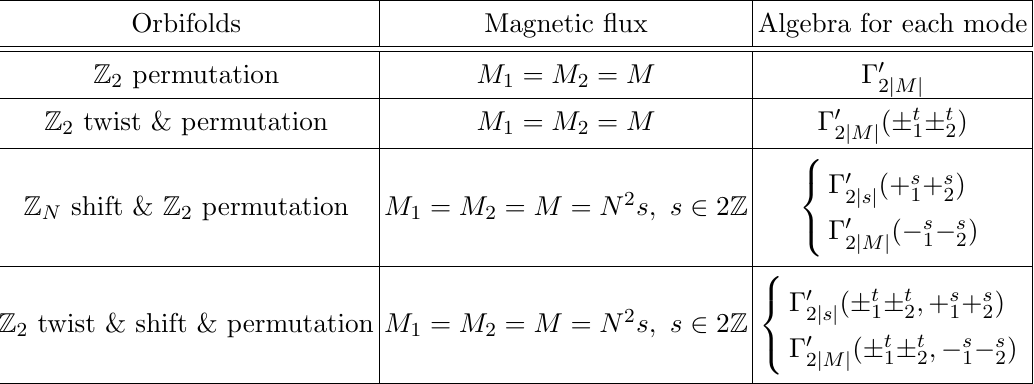
Table 3 . The algebraic relations for the unitary representation on the ( T 2 and permutation orbifolds. The (cid:12)rst column shows the types of orbifolds. The second column shows the magnetic (cid:13)uxes. The last column shows the algebraic relations for the unitary representation. The notation is same with table 1.